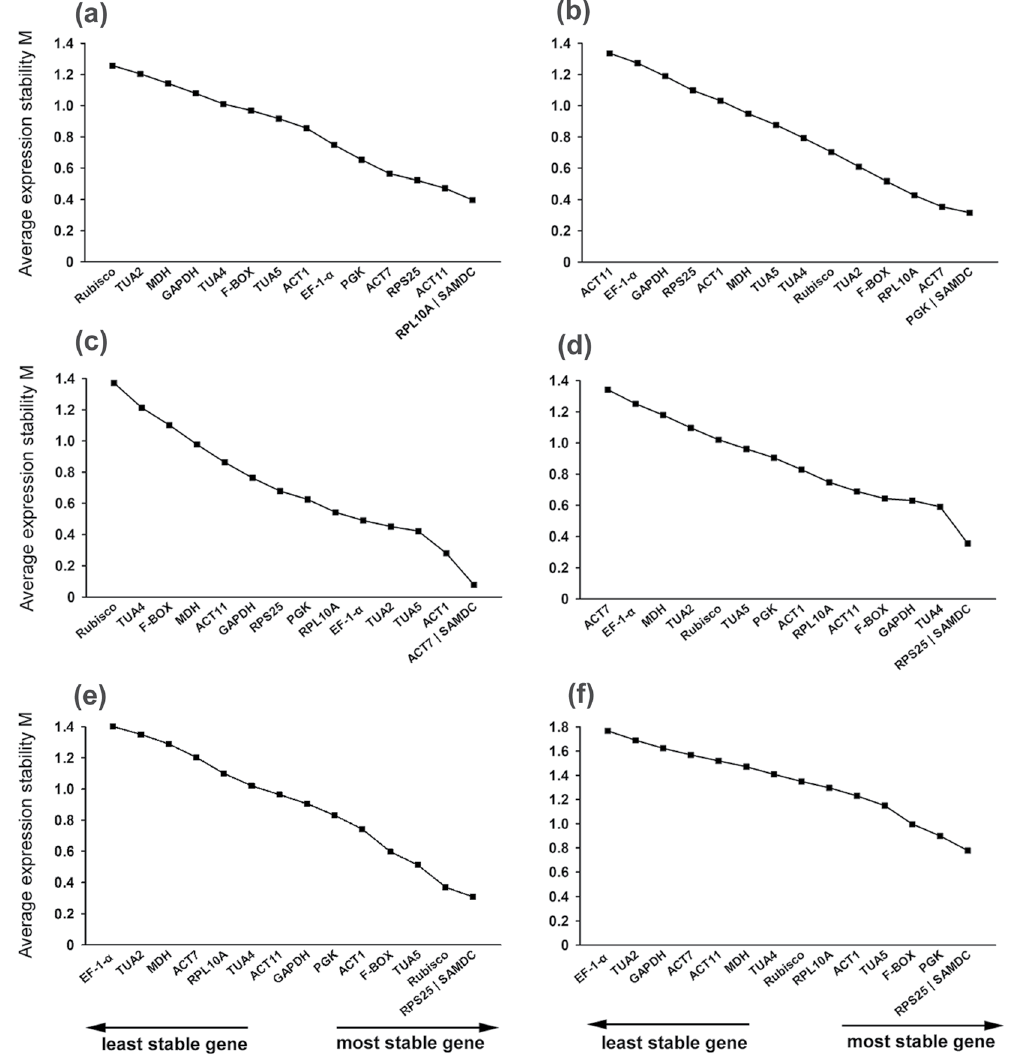
Figure 2. Average expression stability values (M) of 15 candidate reference genes calculated by geNorm. ( a ) Tissue; ( b ) developmental stage; ( c ) photosynthetic cycles; ( d ) drought treatment; ( e ) cold treatment; ( f) all of the samples in our given conditions.